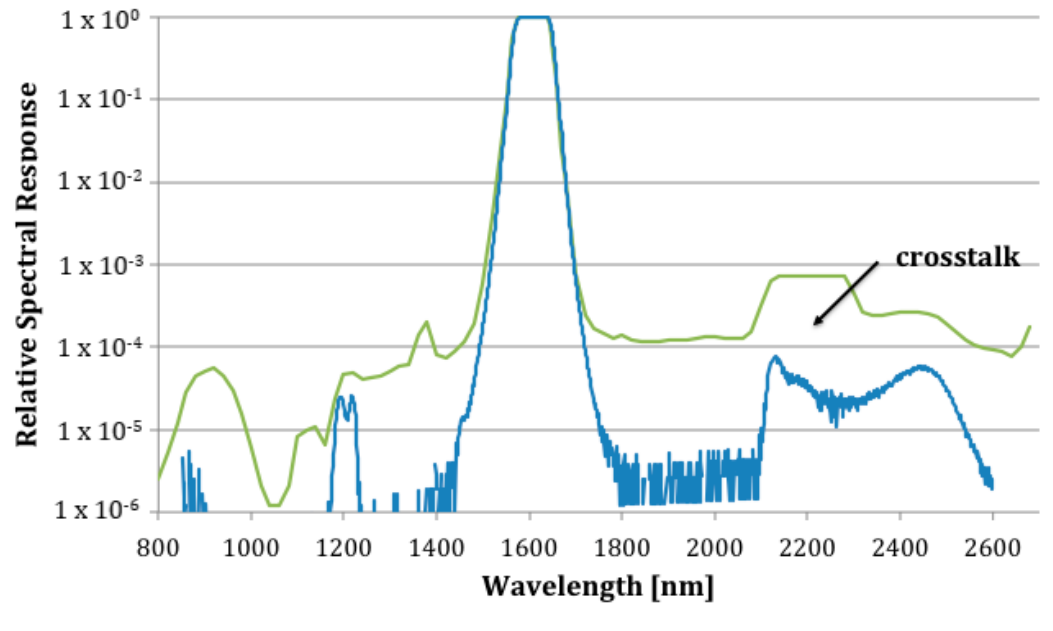
Figure 2. Relative spectral response (RSR) for OLI-2 SWIR1 Band and Focal Plane Module (FPM) 9. Blue curve shows component level result, green curve shows the RSR at the module level. Note the substantial loss in out-of-band rejection due to interaction between FPM components.